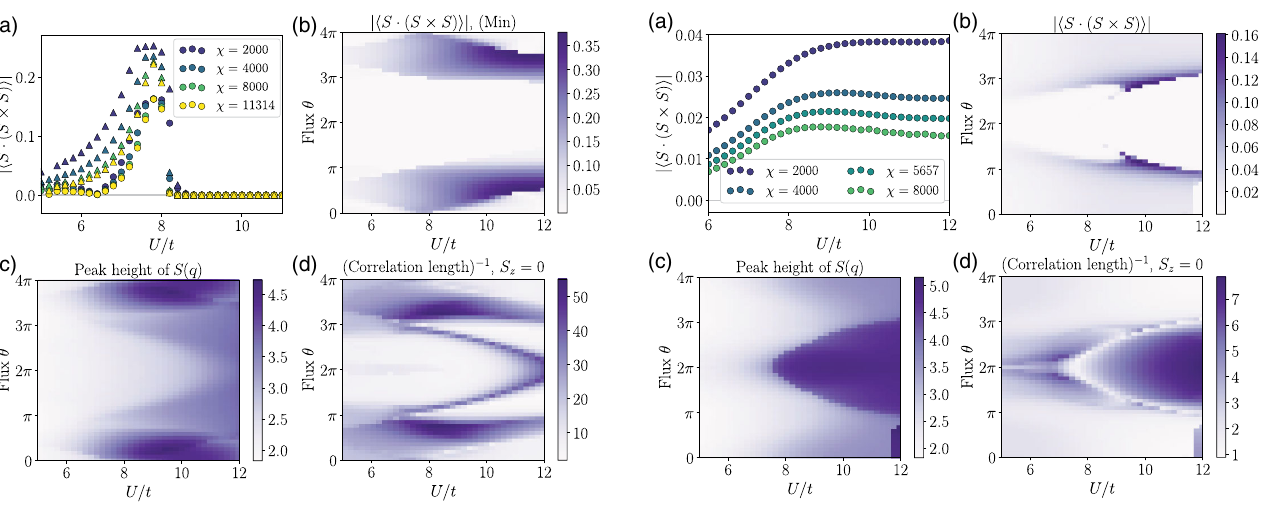
FIG. 11. Results for the YC3 cylinder. (a) Chiral order parameter on each of two rings (circle and triangle symbols, respectively), plotted versus U=t for a range of bond dimensions. The behavior is qualitatively similar to that of YC4 and YC6. (b) Chiral order parameter versus U=t and flux insertion θ , for χ ¼ 4000 . Here we show just the smaller of the chiral order parameters on the two rings, but the qualitative behavior is essentially identical at this bond dimension. (c) Peak height of the h S z S z i structure factor in the Brillouin zone. (d) Inverse corre- lation length for excitations with S z ¼ 0 .